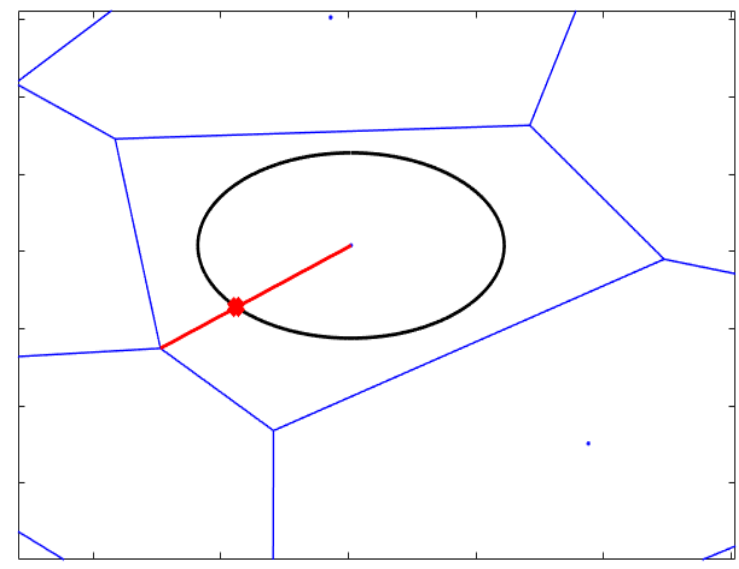
Figure 6. Irregular shape center zone vertex of the small cells.